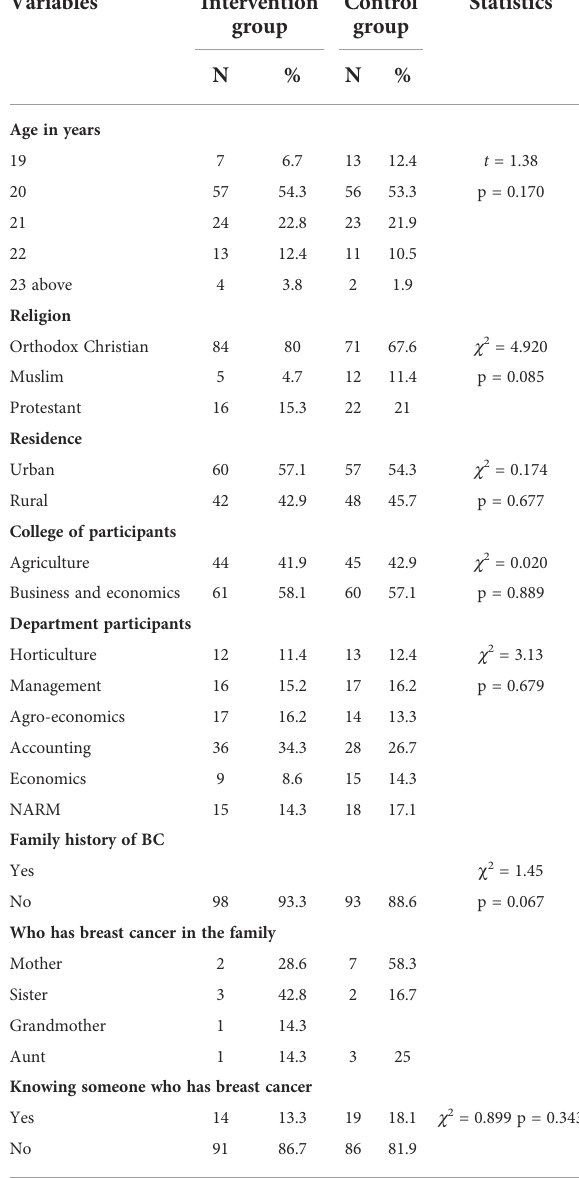
TABLE 1 Socio-demographic characteristics of intervention and control groups with comparison among female students of Debre Markos University, Amhara, Ethiopia before and 1 month after educational intervention about BC based on HBM ( n = 210) 2021. Variables Intervention Control group